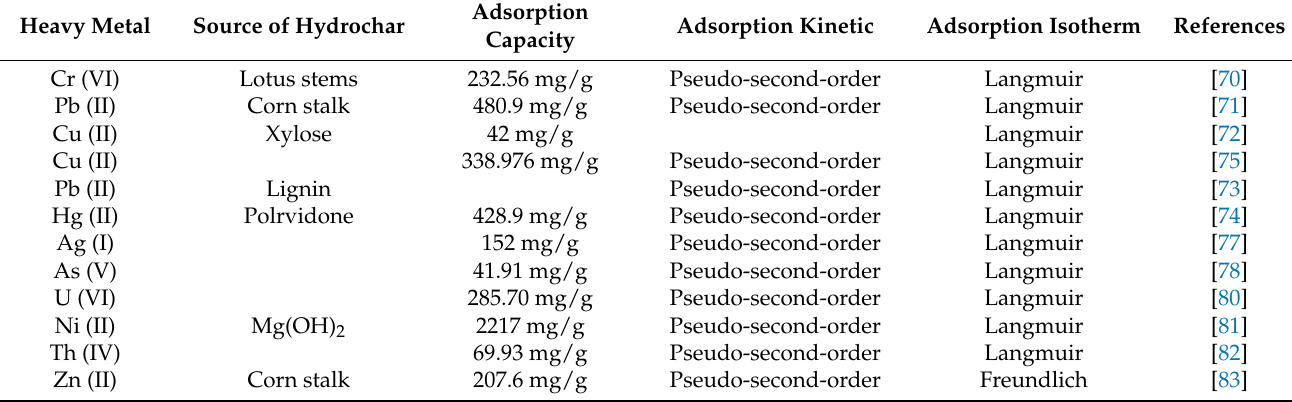
Table 3. Adsorption of heavy metals in water by